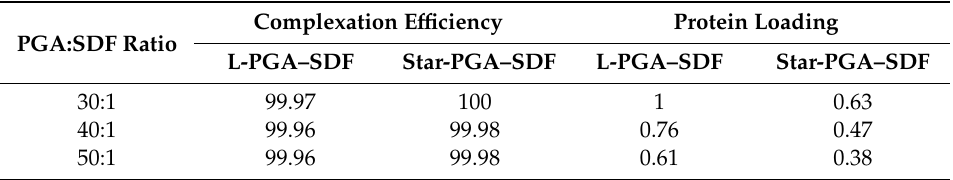
Table 2. Complexation e ffi ciency % w / w and protein loading content % w / w of L-poly(glutamic